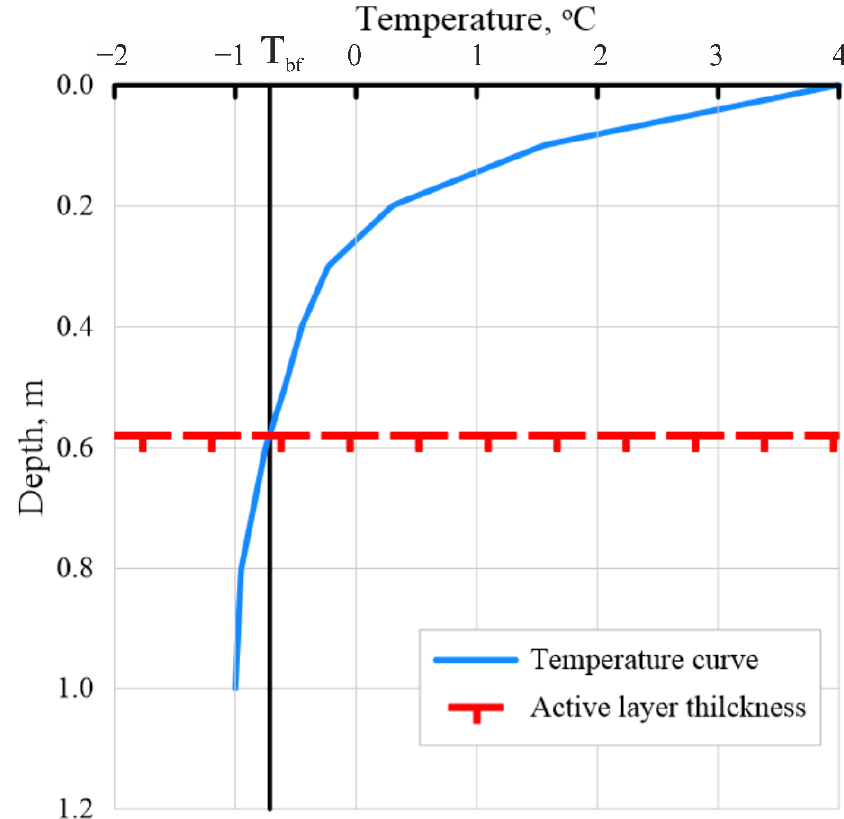
Figure 2. Determination of the thickness of permafrost active layer for silty clays (T bf — the temperature of beginning of ground freezing).